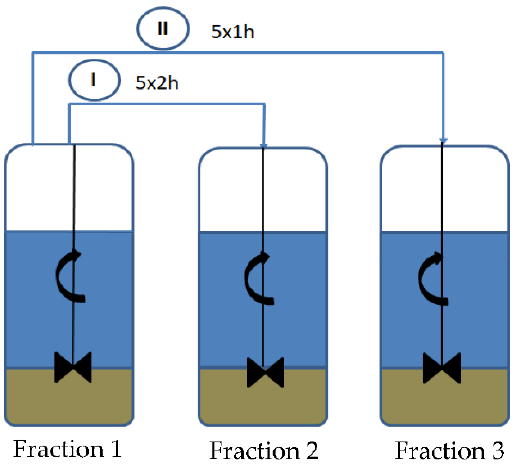
Table 2. The weight of sediments obtained.